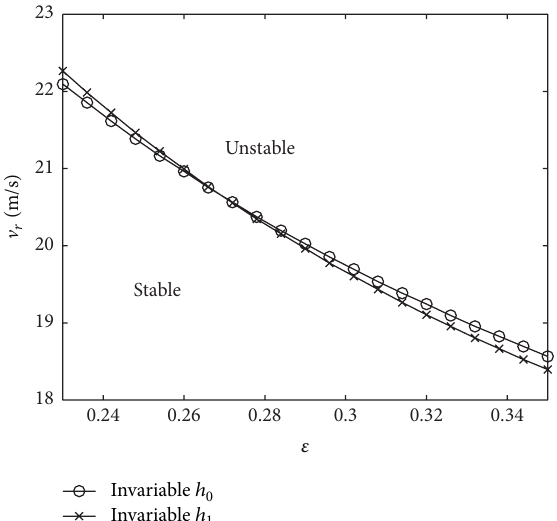
Figure 13: Influence of reduction ratio on system stability.